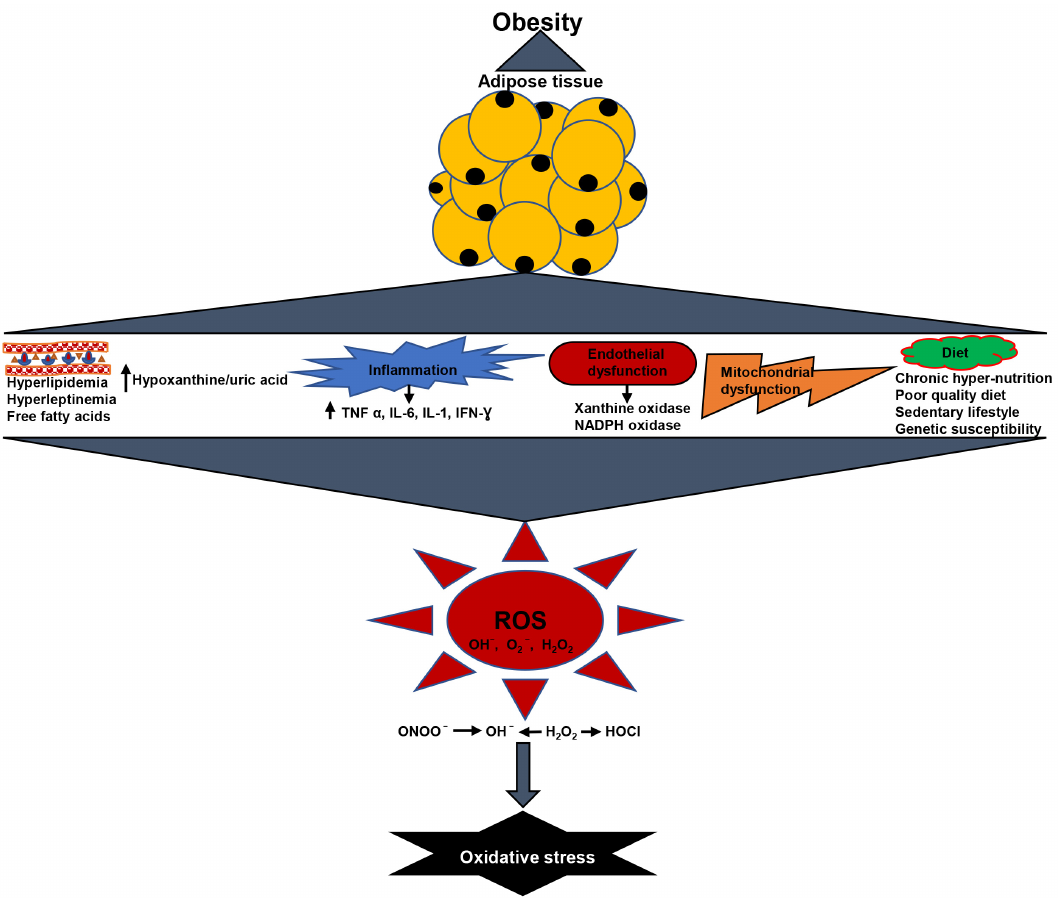
Figure 1. Oxidative stress generation via ROS production in obesity.